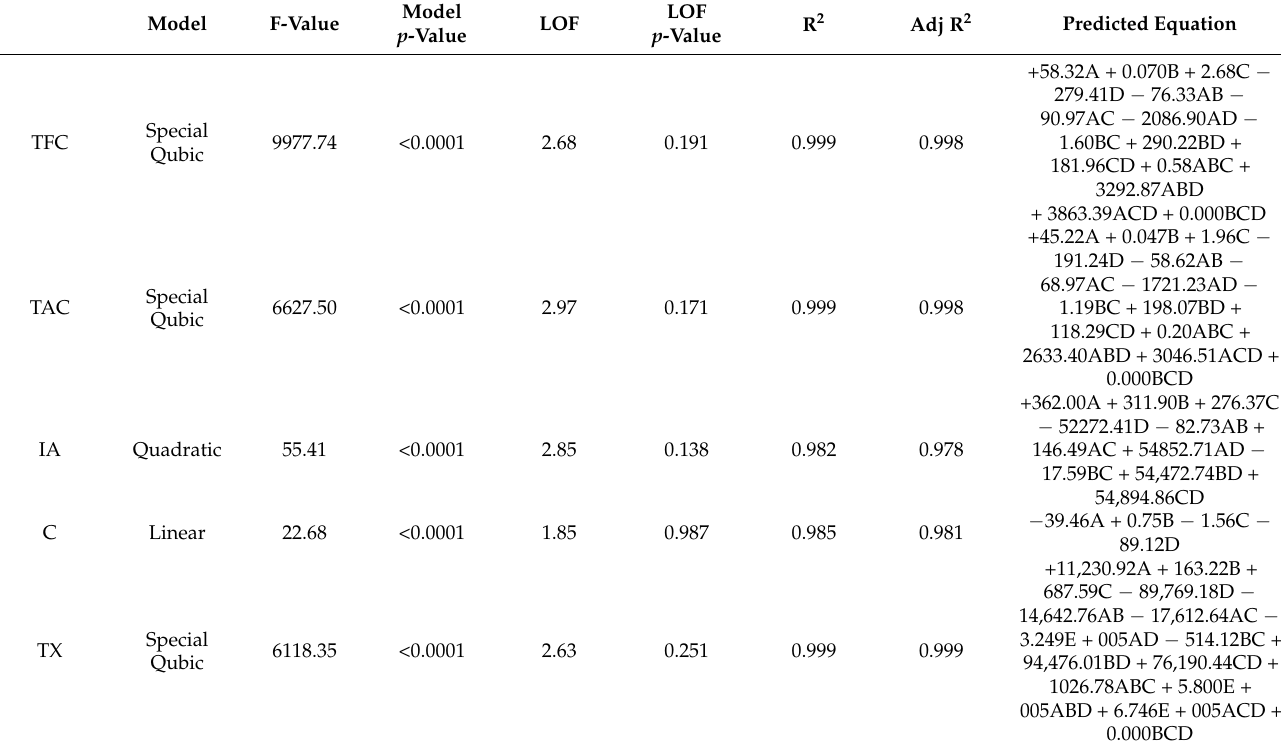
Table 3. Model fitting for each response and the obtained statistical data when applying ANOVA of lack of fit and regression of the selected